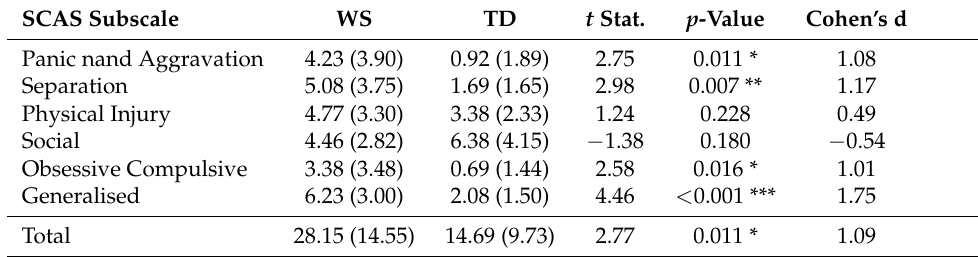
Table 3. Group mean scores, standard deviations, and group differences in SCAS. SCAS Subscale